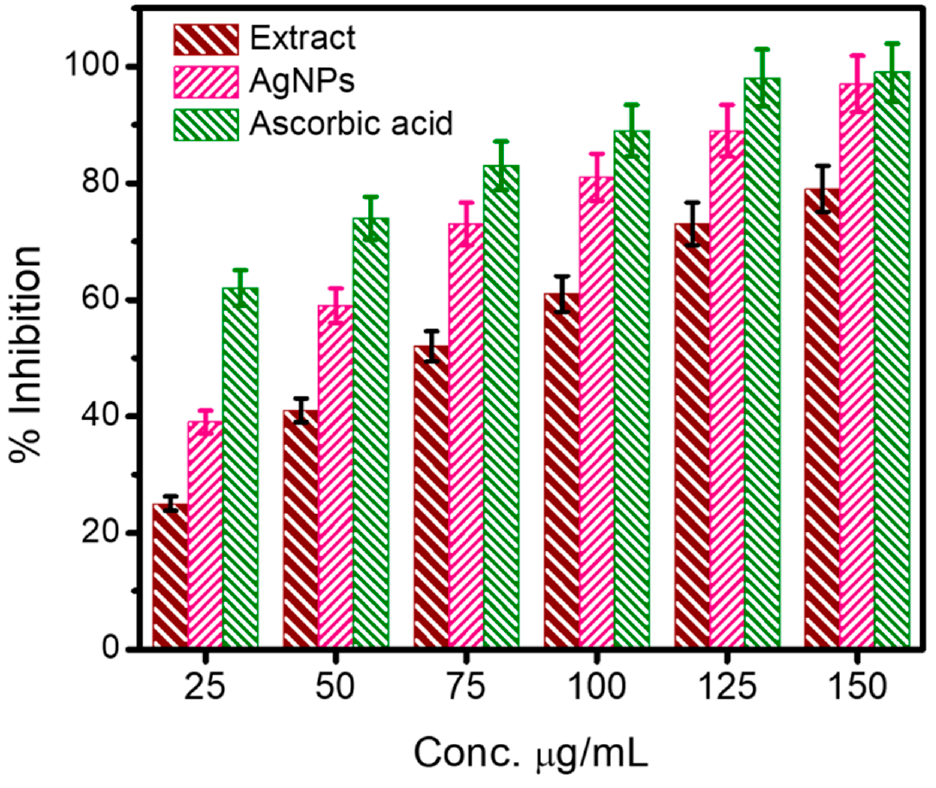
Figure 5. DPPH scavenging activity of the extract, Ca-AgNPs, and ascorbic acid at various concentrations (µg/mL) .